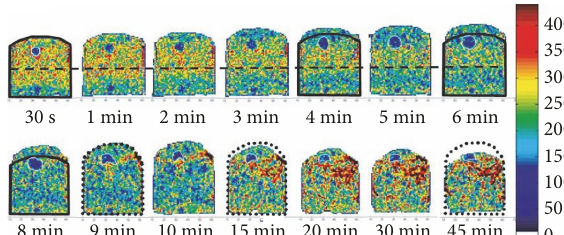
Figure 2: Normalized magnetic resonance images (MRI) of bread acquired during baking. That is, during baking, the cold colors convert to warm colors corresponding to low to high signal intensities, respectively [65].